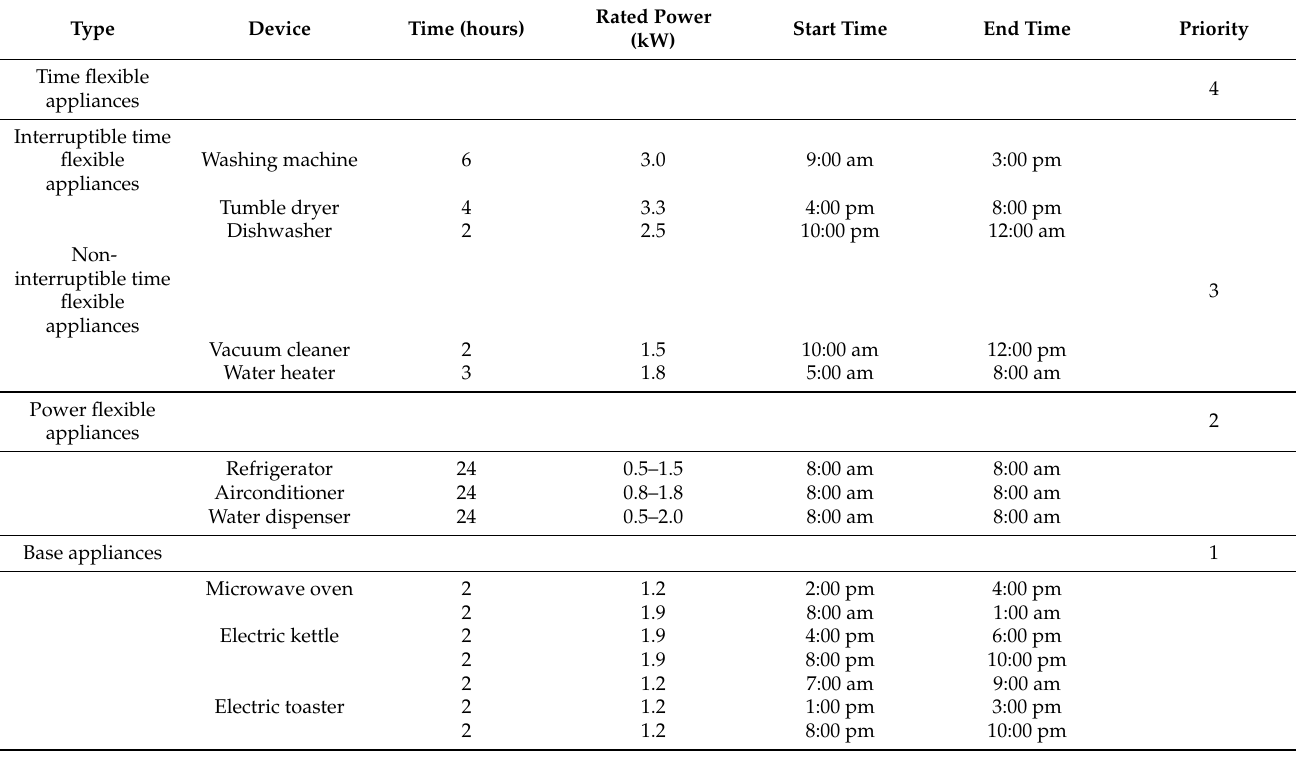
Table 2. Smart appliances control parameters like duration, operation time interval, priority,